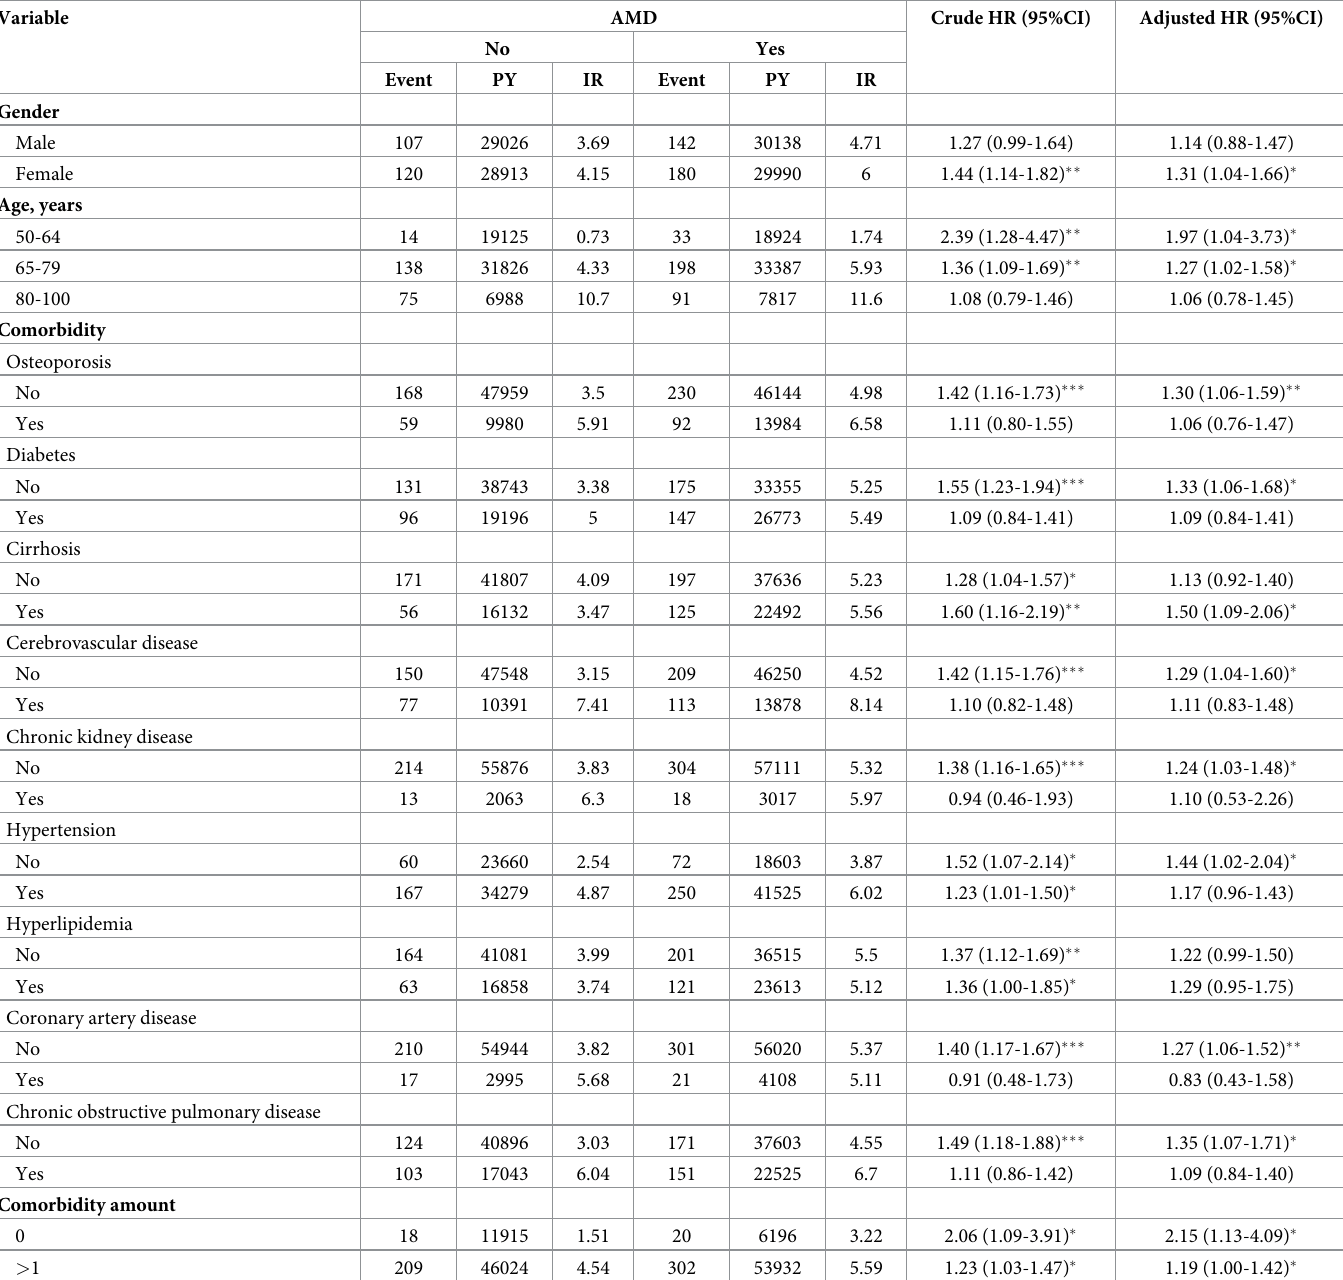
Table 3. Incidence rates, hazard ratios, and confidence intervals of Alzheimer’s disease in patients with AMD stratified by gender, age and comorbidity.